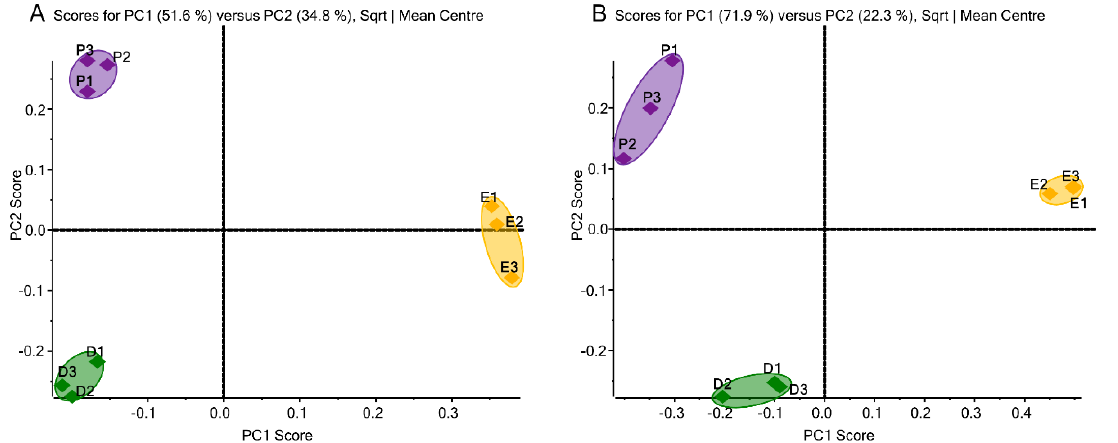
Figure 4. Unsupervised principal component analysis of O -glycans derived from ( A ) the 231BR cell line, with 20 glycans, 9 glycans, and 22 glycans identified in DMEM, EMEM, and Plasmax, respectively, and ( B ) the CRL cell line, with 28 glycans, 18 glycans, and 27 glycans identified in DMEM, EMEM, and Plasmax, respectively. Symbols are the same as in Figure 1.